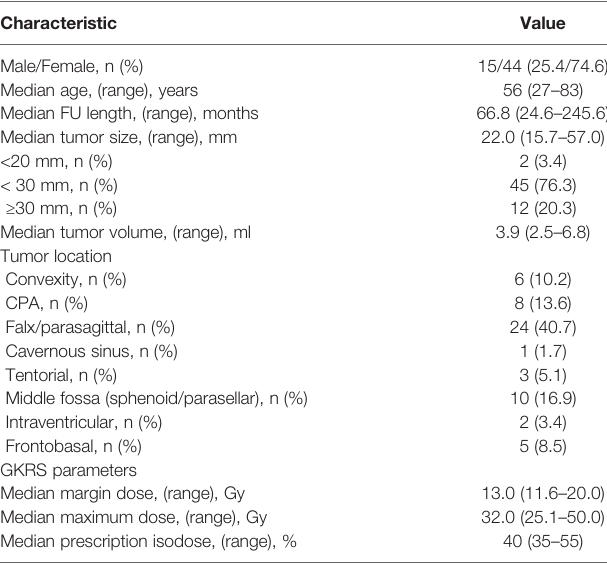
TABLE 1 | Characteristics of 59 patients with 59 asymptomatic meningiomas and GKRS parameters. Characteristic